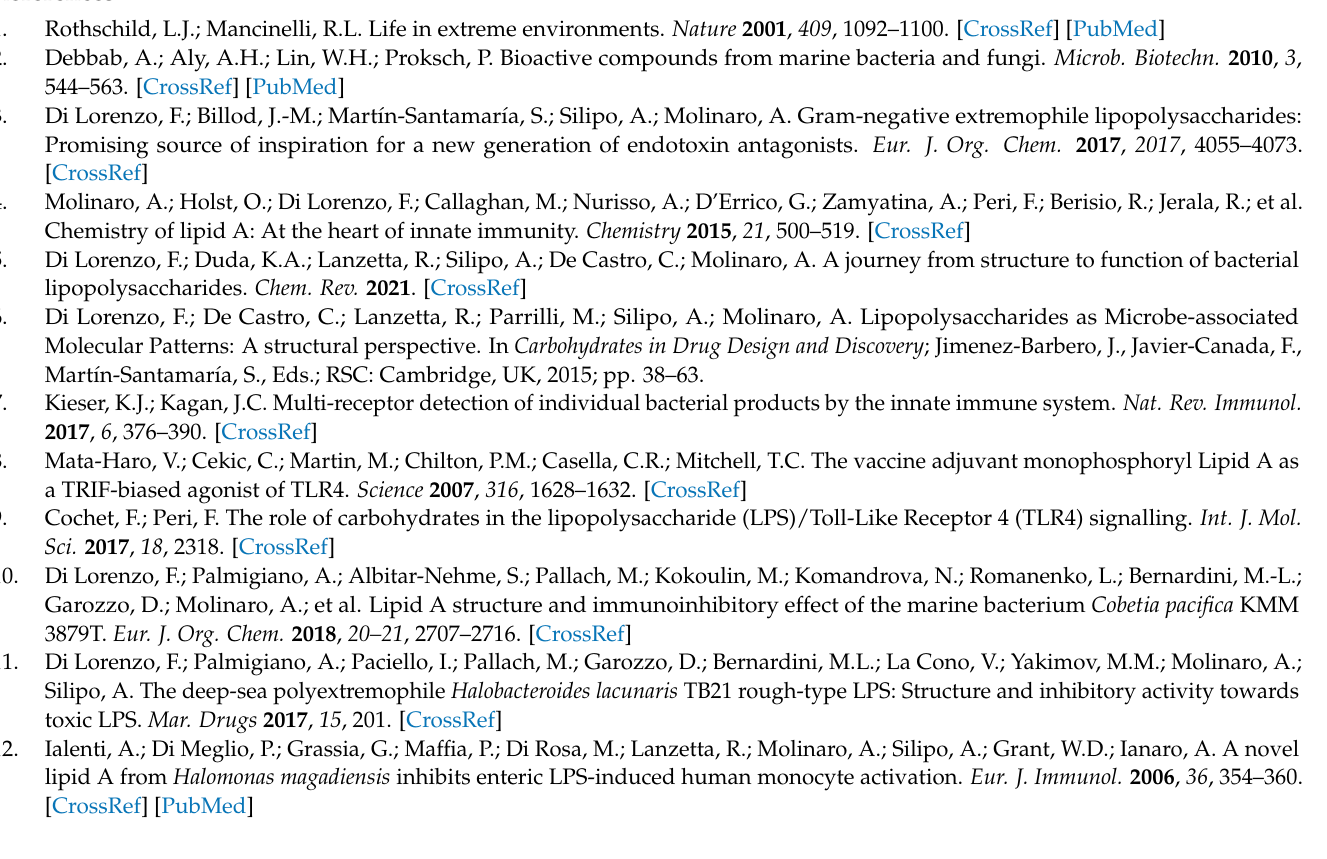
spectrum; Figure S4: Negative-ion MALDI MS/MS spectrum of precursor ion at m / z 1621.8, another representative ion peak of the cluster assigned to tetra-acylated lipid A species from E. pacifica KMM 6172 T ; Figure S5: Negative-ion MALDI MS/MS spectrum of precursor ion at m / z 1513.7, related to tetra-acylated lipid A species from E. vietnamensis KMM 6221 T ; Figure S6: Stimulation of HEK Blue TM Null2 TM cells. SEAP levels (OD) (a) and IL-8 release (b) upon stimulation with LPS of E. pacifica KMM 6172 T (1, 10, 100 ng/mL) or E. vietnamensis KMM 6221 T LPS (1, 10, 100 ng/mL); S. typhimurium SH 2201 LPS was used as positive control; Figure S7: Stimulation of HEK Blue TM hTLR2 cells. SEAP levels (OD) (a) and IL-8 release (pg/mL) ( b ) upon stimulation with LPS of E. pacifica KMM 6172 T (1, 10, 100 ng/mL) or E. vietnamensis KMM 6221 T LPS (1, 10, 100 ng/mL); S. typhimurium SH 2201 LPS or Pam3CSK4 (500 ng/mL) were used as positive and negative controls,